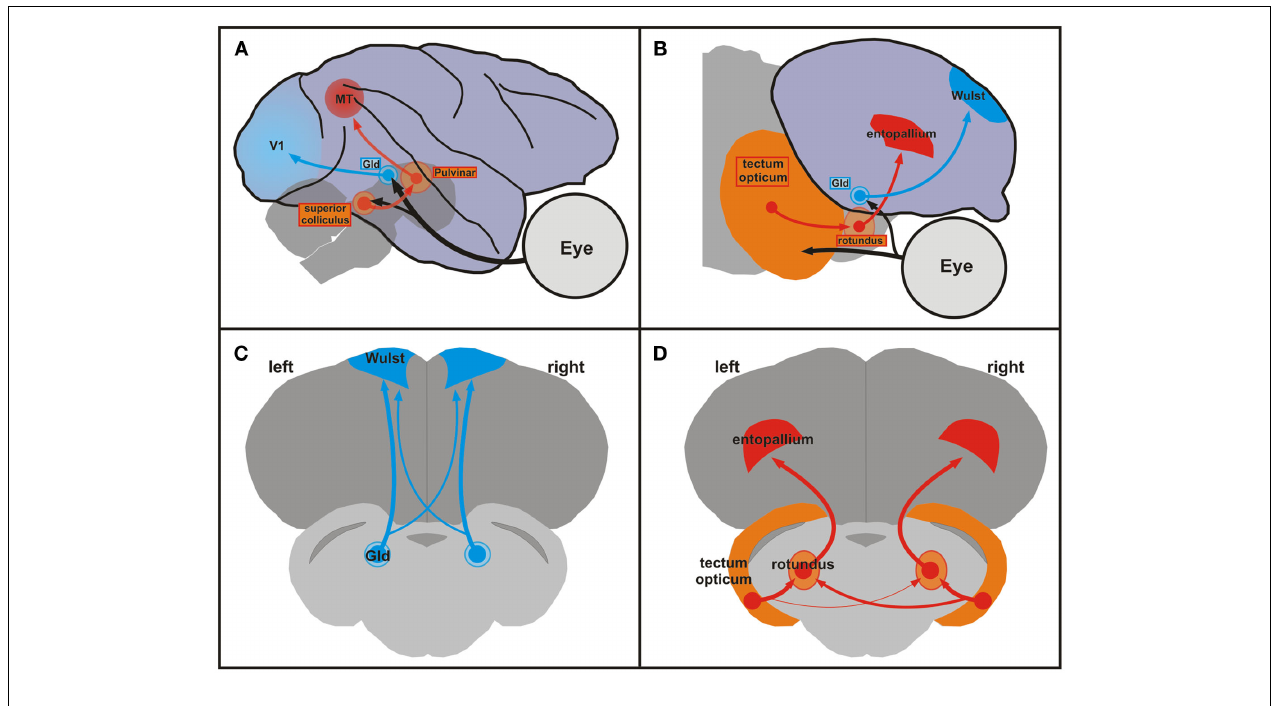
Dorsal is upward and rostral is to the right. (C,D) Schematic frontal views of the forebrain and brainstem of the pigeon brain showing the thalamofugal (C) and the tectofugal (D) pathways. Note the larger right-to-left projection of the tectorotundal efferents in the tectofugal system (D) .The organization of the sections in (C,D) shows all relevant components within the same plane and is not anatomically correct. Abbreviations: GLd, nucleus geniculatus lateralis pars dorsalis; MT, middle temporal visual area (alsoV5); V1, primary visual